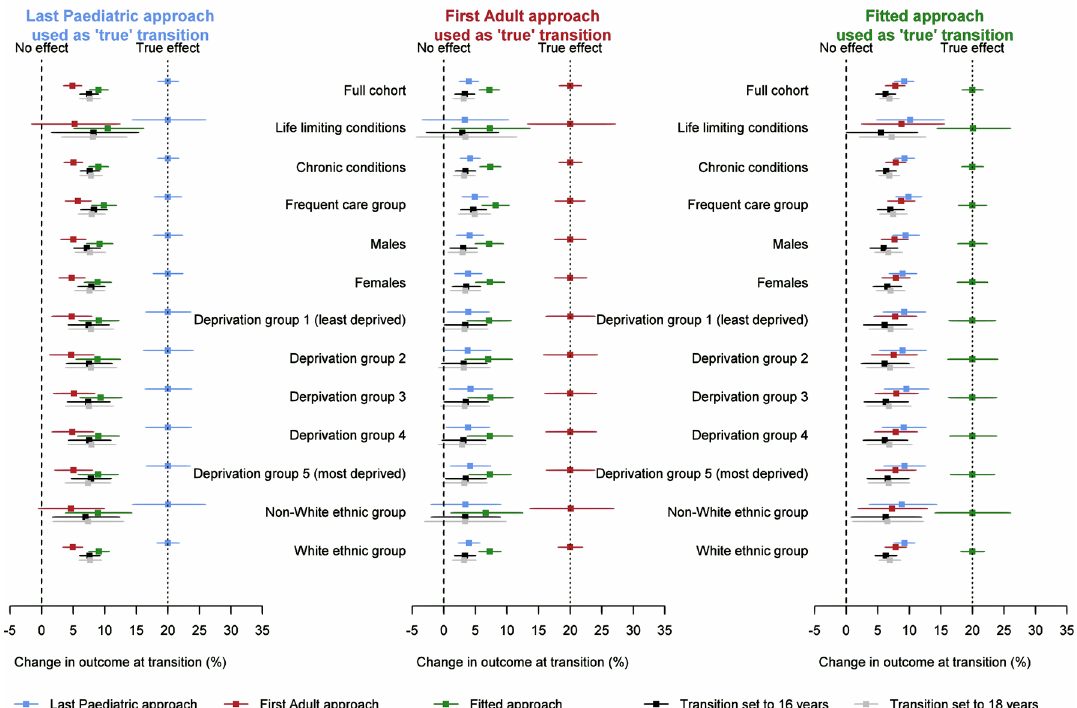
Figure 8: Observed changes associated with transition, from Poisson regressions of simulated outcomes for the whole cohort and indicated